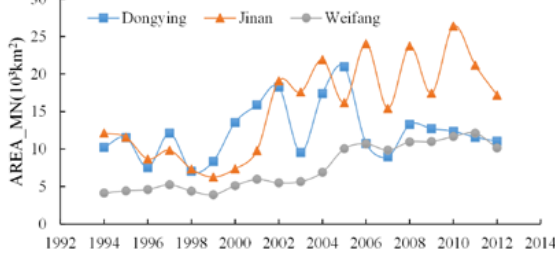
Figure 6. The variation of AREA_MN metric of Dongying, Jinan, and Weifang